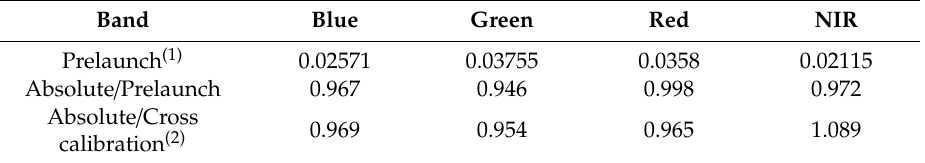
Table 9. Comparison of the calibration Gain coe ffi cients with other